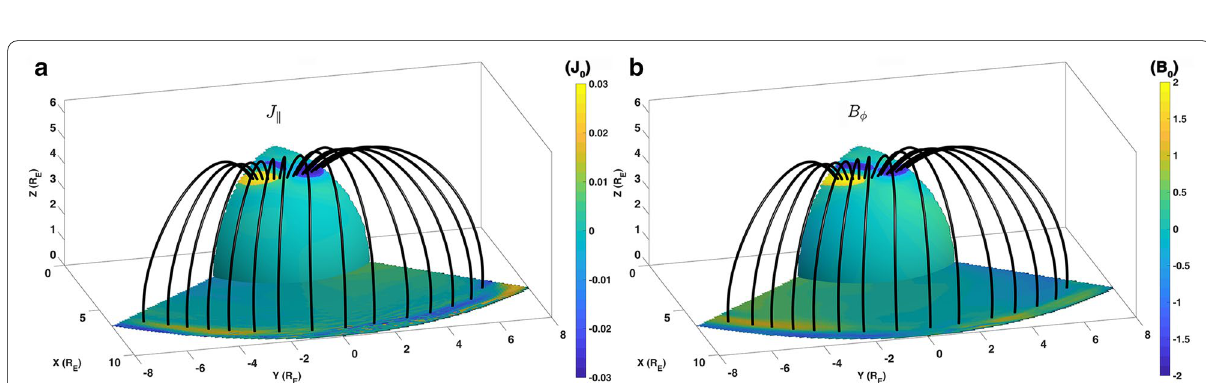
4 R E , with typical magnetic field lines =